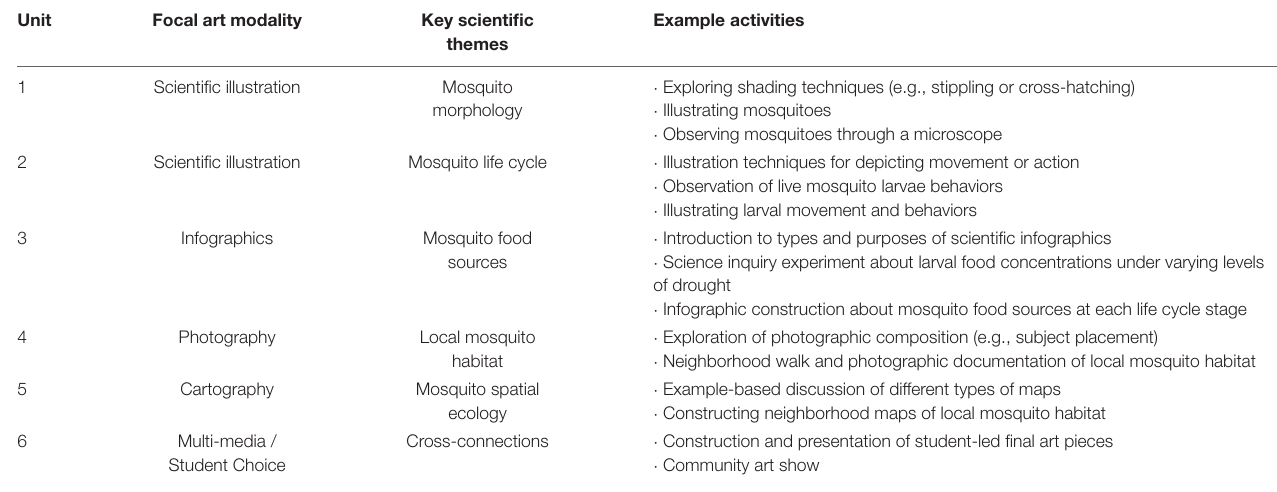
TABLE 1 | Weekly Buzzing for Blood